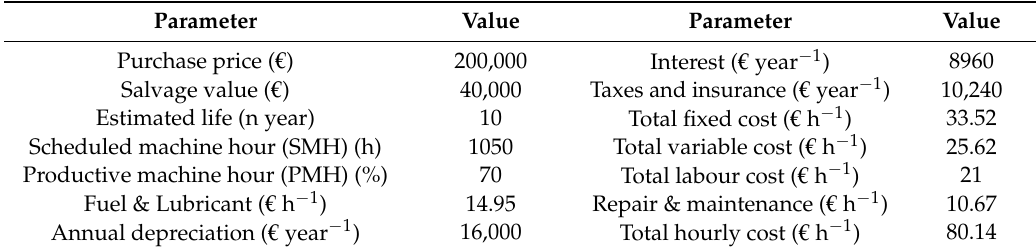
Table 3. Assumed cost parameters for machine rate